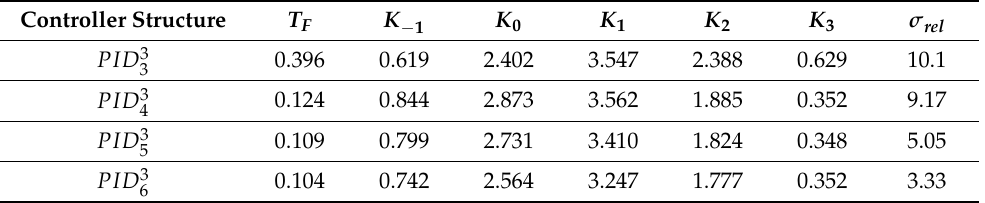
Table 4. The calculated filter time constants T F and controller parameters at different n . Controller Structure